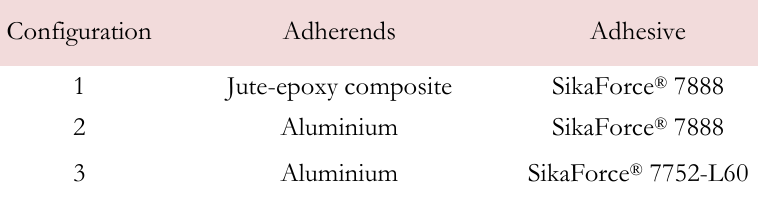
Table 1: Configurations tested to measure G nc .